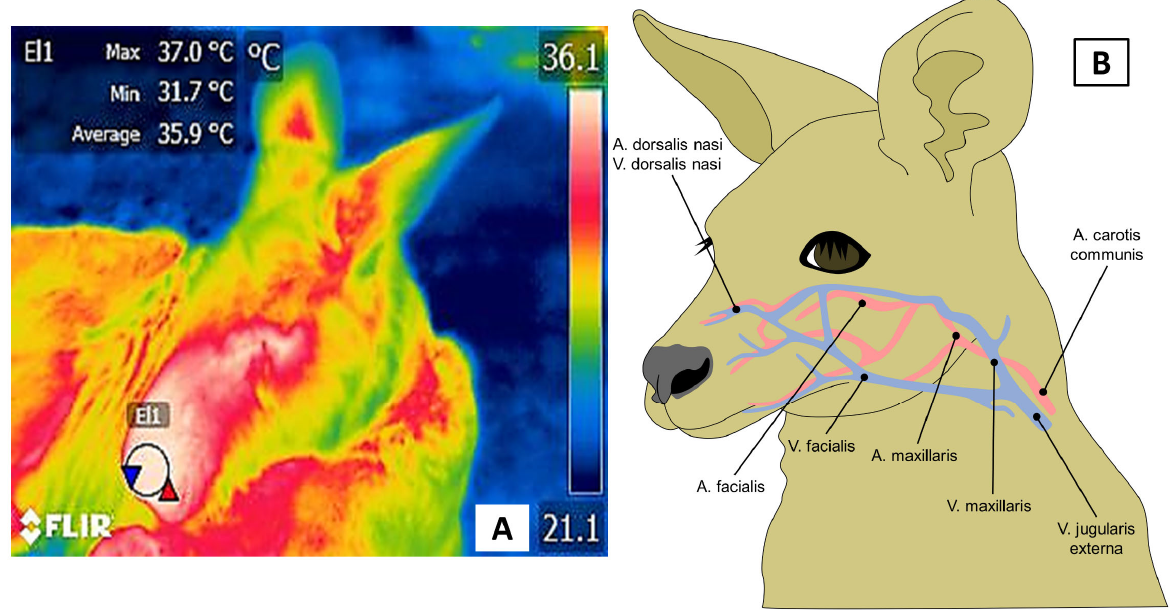
Figure 7. Nasal window in a kangaroo ( Osphranter rufus ). ( A ). A circle around the nasal region, including both nostrils, delimits the nasal window. ( B ). Circulation in the nose depends on branches of the maxillary artery and the a. facialis and a. and v. dorsalis nasi , which are innervated by the facial nerve.